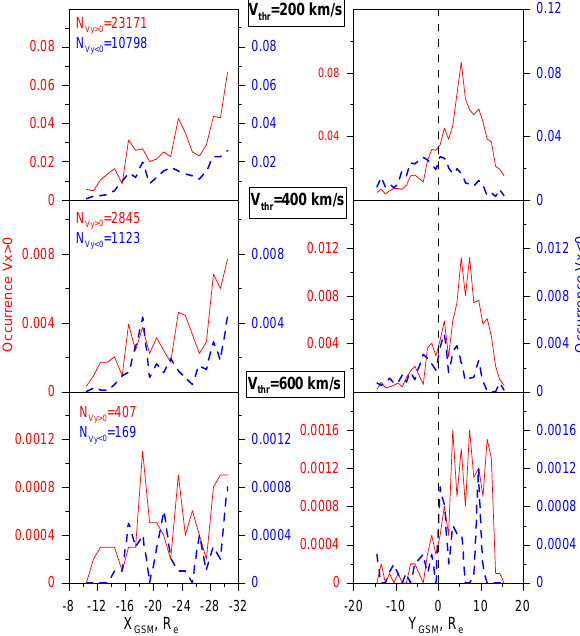
Figure 1 Occurrence frequency of the |Vx|>Vthr (red) and |Vy|>Vthr (blue) samples Fig. 1. Occurrence frequency of the | V x | >V thr (red) and | V y | >V thr depending on the X (left column) and Y (right column) GSM coordinates for three different velocity thresholds (200,400 and 600 km/s).The number of events for each (blue) samples, depending on the X (left column) and Y (right col- distribution is indicated. umn) GSM coordinates for three different velocity thresholds (200, 400 and 600km/s). The number of events for each distribution is indicated.